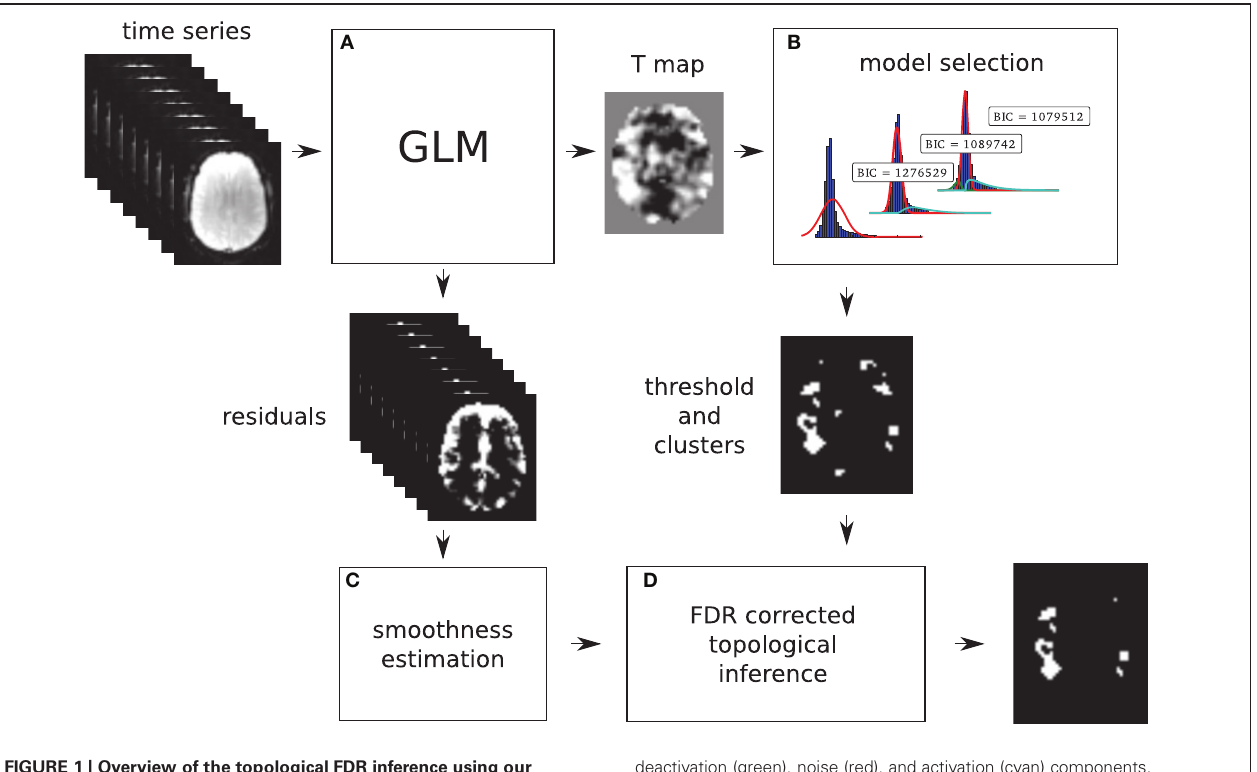
FIGURE 1 | Overview of the topological FDR inference using our Gamma-Gaussian mixture model to set adaptively the cluster forming threshold. GLM produces T-map and residuals (A) Three models are being fitted to the voxels from the T-map (B) Models include a combination of